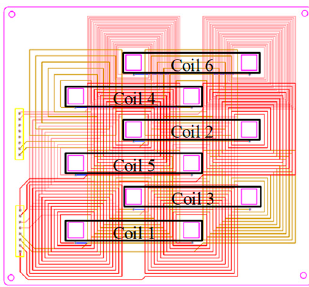
Figure 13. Printed circuit board (PCB) layout of the three ‐ layer hexagonal layout detection coils. Table 1. Detection coil parameters.